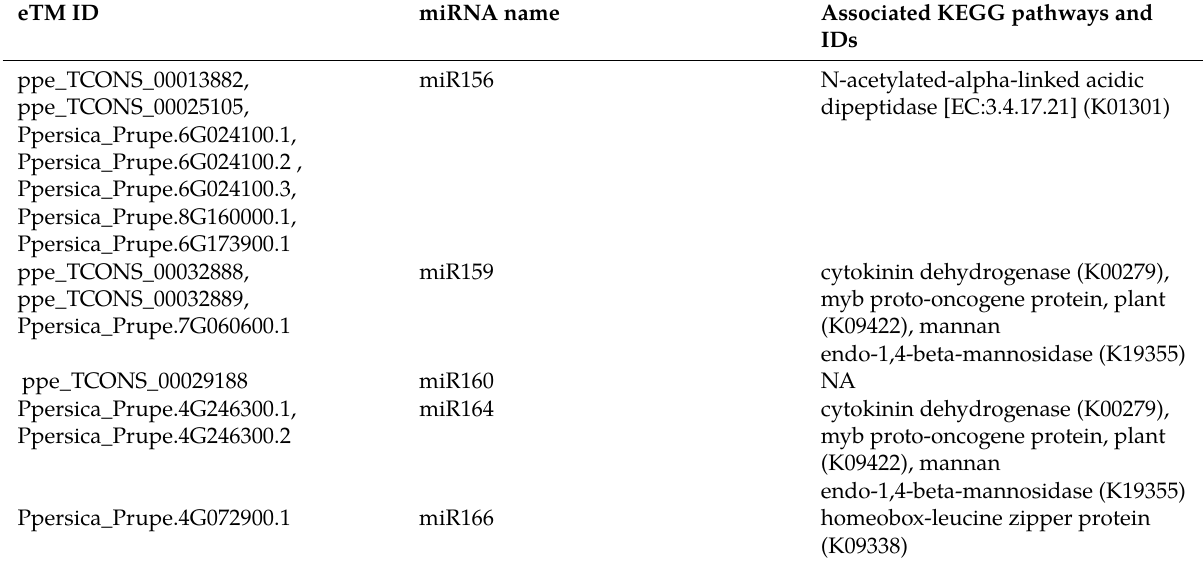
Table 1: KEGG pathways potentially regulated by ETM-targeted miRNAs. eTM ID miRNA name Associated KEGG pathways and